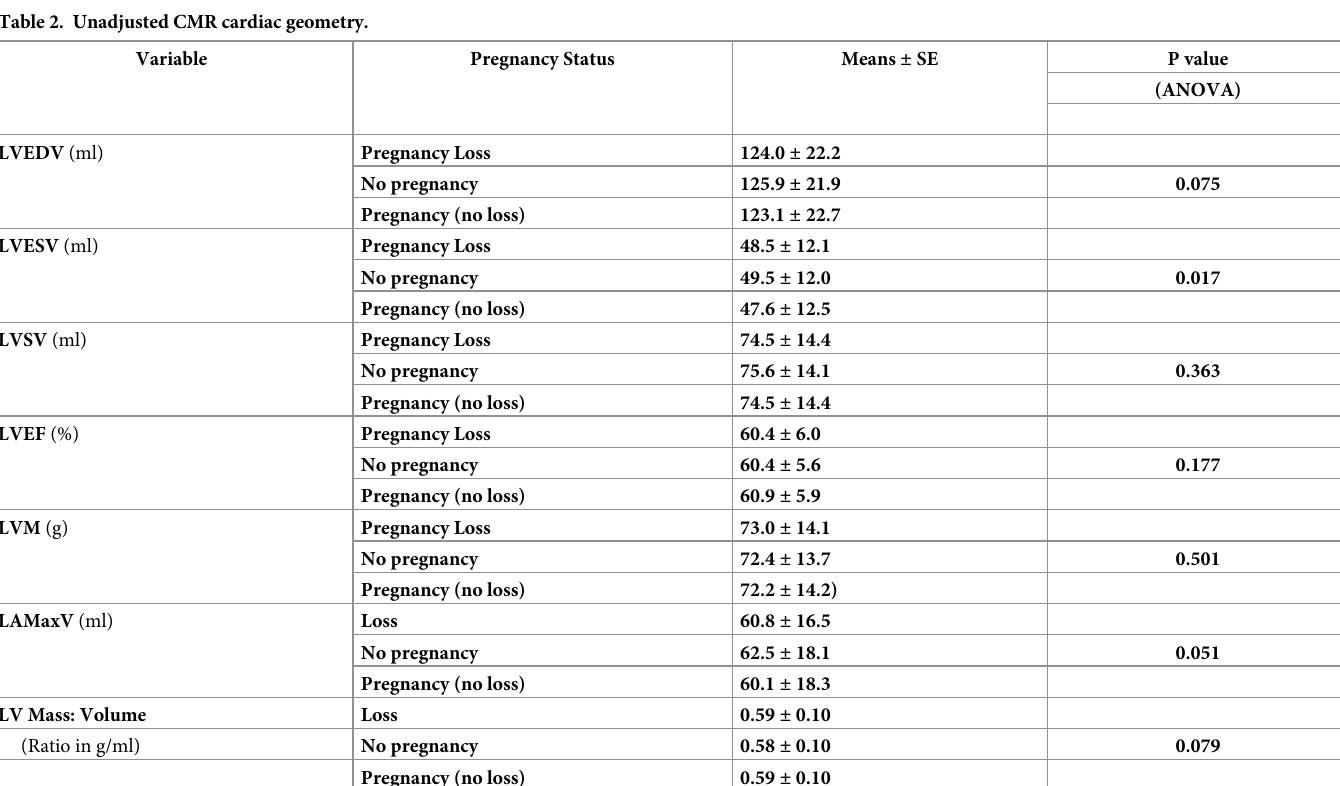
Table 2. Unadjusted CMR cardiac